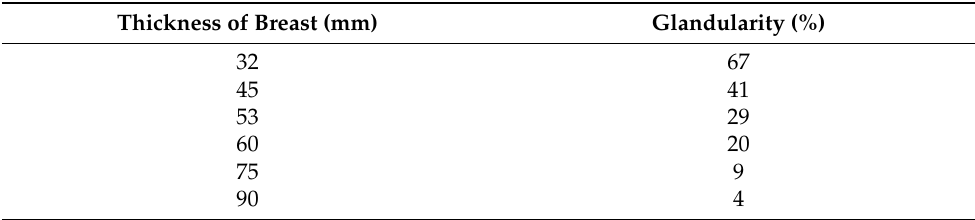
Table 2. Typical values of glandularity corresponding to breasts of a given thickness after compression according to the European Guidelines for Quality Assurance in Breast Cancer Screening and Diagnosis (4th Edition) [33].